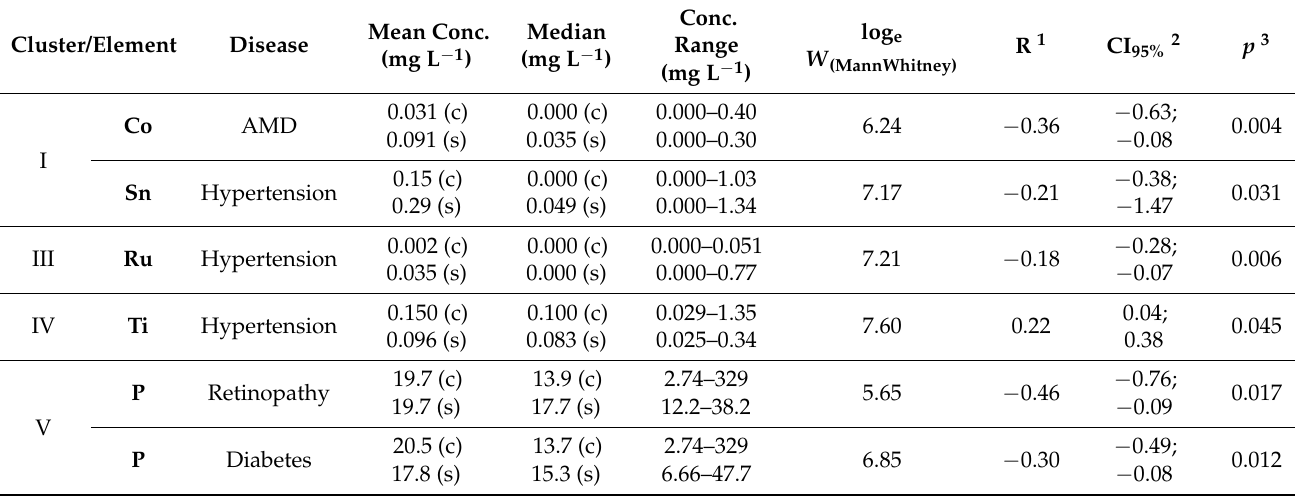
Table 2. Results of statistically significant differences between studied (s) and control (c) patients’ groups enrolled in the study performed by non-parametric Mann–Whitney U testing.